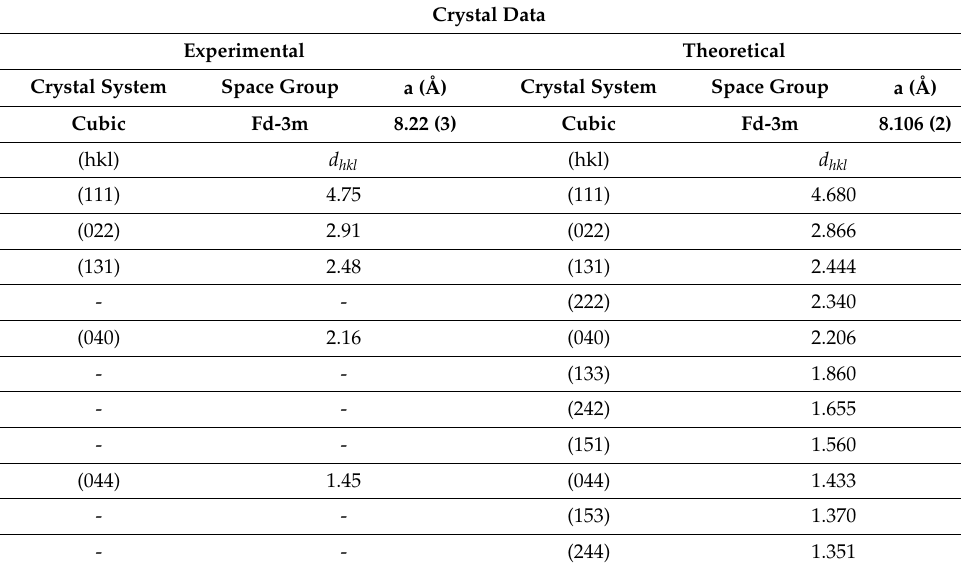
Table 2. Crystallographic analysis of CrAl 2 O 4 (isostructural with MgAl 2 O 4 ).